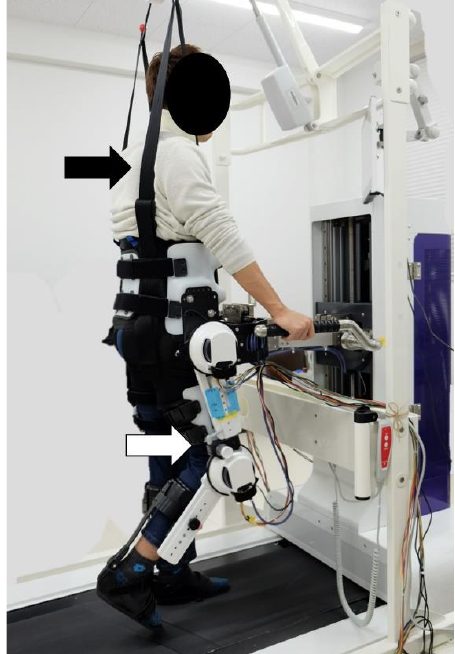
Figure 4. A walking training rehabilitation robot with functional electrical stimulation (FES) for paraplegia. The exoskeleton is made based on the long leg orthotic device, and the rehabilitation unloading lift (black thick arrow), FES and robot orthotic device (white thick arrow) are attached, and walking exercise is performed on the treadmill.